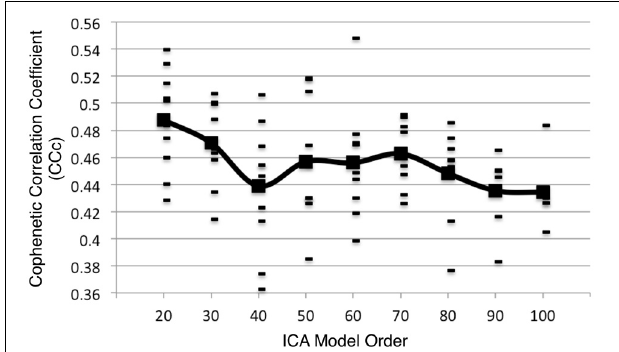
FIGURE 8 | Additional analyses were performed on 10 random subsets of 90% of the experiments in the BrainMap database at the time of the initial analysis following the same procedure as outlined in Figure 1 (up to d = 100). The CCc values resulting from the 90% subsets follow a similar trend as shown in Figure 3 when averaging across all